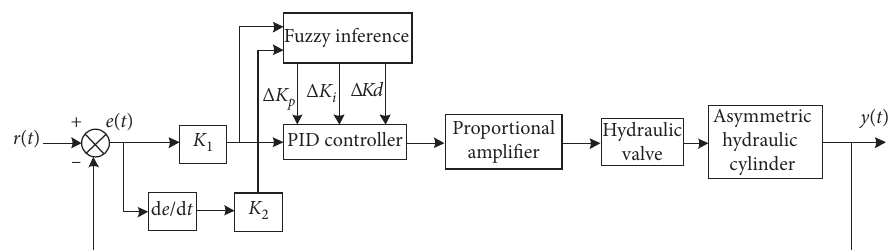
Figure 2: Schematic diagram of fuzzy PID control.